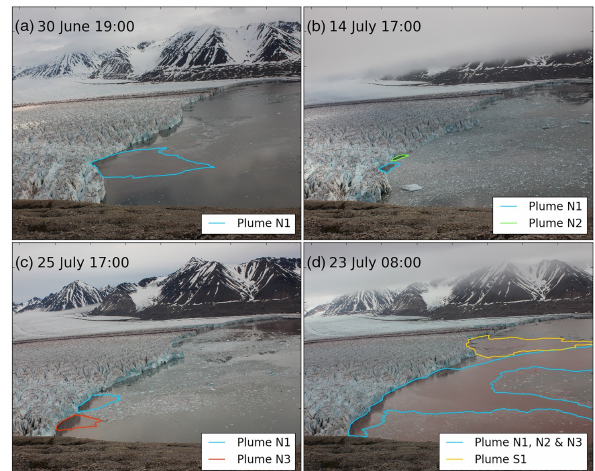
Figure 4. Meltwater plume scenarios from time-lapse imagery at Kronebreen. Top-left to bottom-right: (a) surfacing meltwater plume from the main source on the northern side of the glacier ter- minus, N1; (b) sources from Plume N1 and Plume N2; (c) sources from Plume N1 and Plume N3; (d) sources from all plumes includ- ing Plume S1, the main outlet on the southern side of the glacier